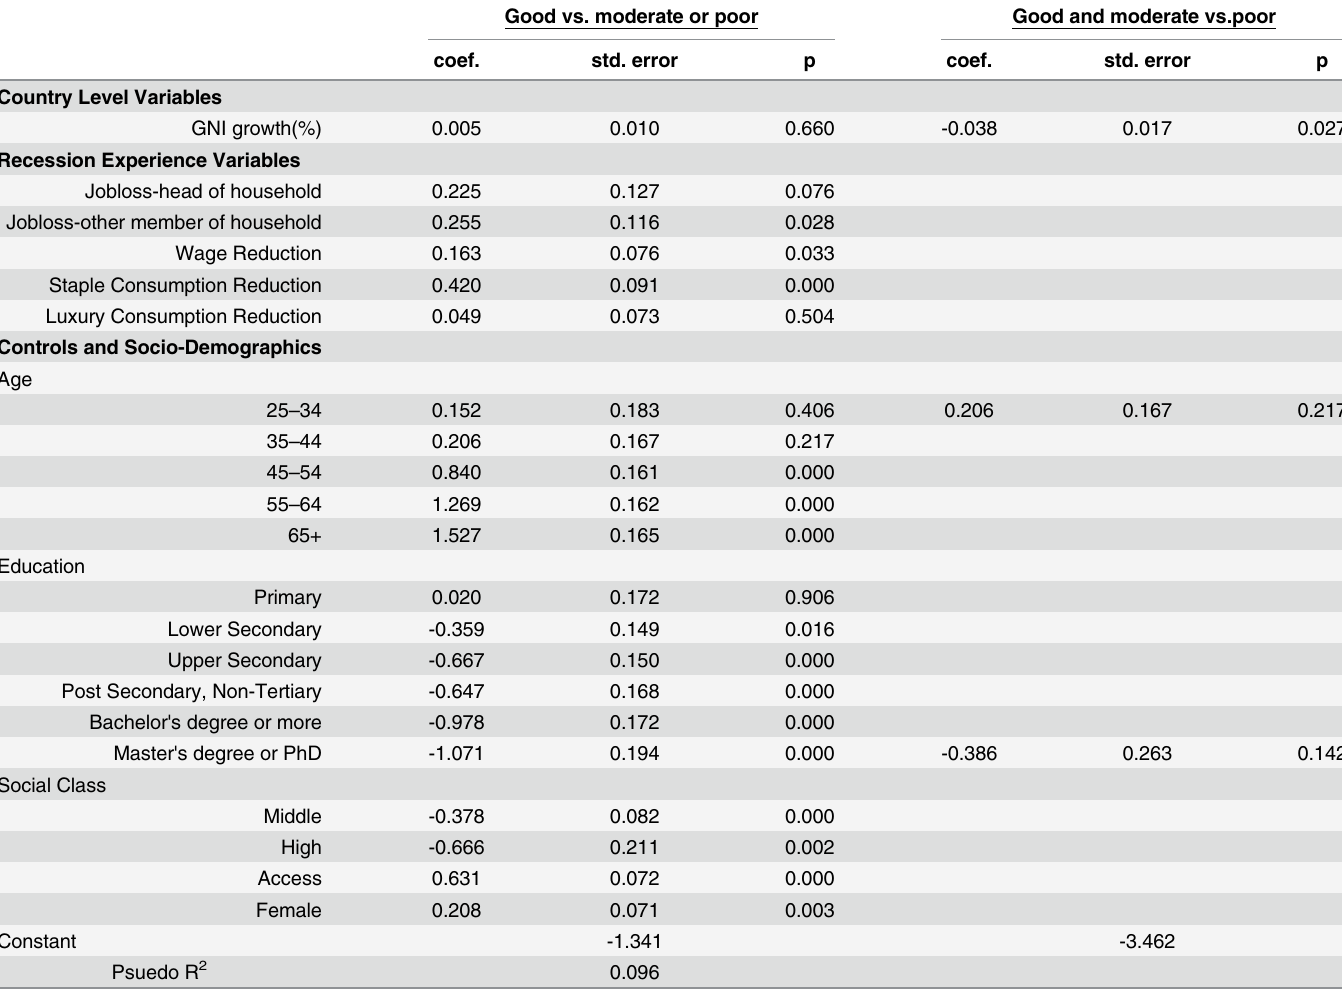
Table 9. Partial Proportional Odds Model for Self Rated Health, fourth GNI per capita quartile ($23,910 to $50, 870). Good vs. moderate or poor Good and moderate